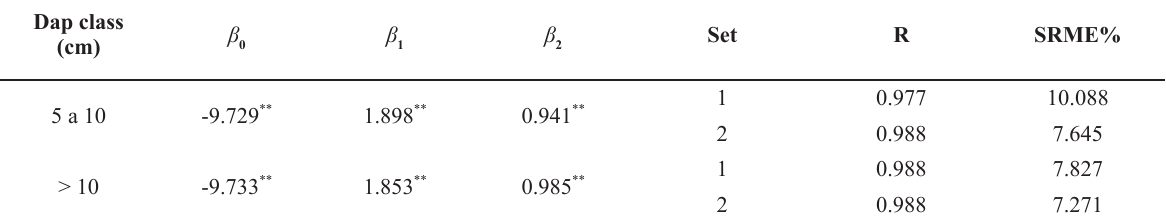
Fit statistical coefficients and indicators of volumetric models fitted by dap class.